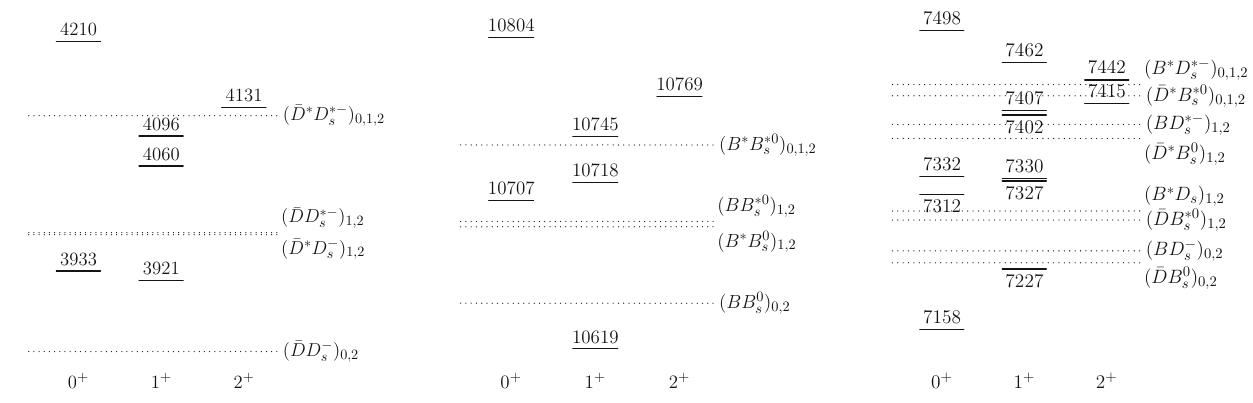
Fig. 3 The estimated masses (units: MeV) of the ns ¯ c ¯ c (left), ns ¯ b ¯ b (middle), and ns ¯ c ¯ b (right) systems in the threshold scheme. The dotted lines are thresholds of the possible decay channels. When the total spin Table 8 Numerical results for the ss ¯ c ¯ c , ss ¯ b ¯ b , and ss ¯ c ¯ b systems in units of MeV. The masses in the sixth column are estimated with the masses of effective quarks and those in the last column with the thresholds of D s D s / B s B s / D s B s